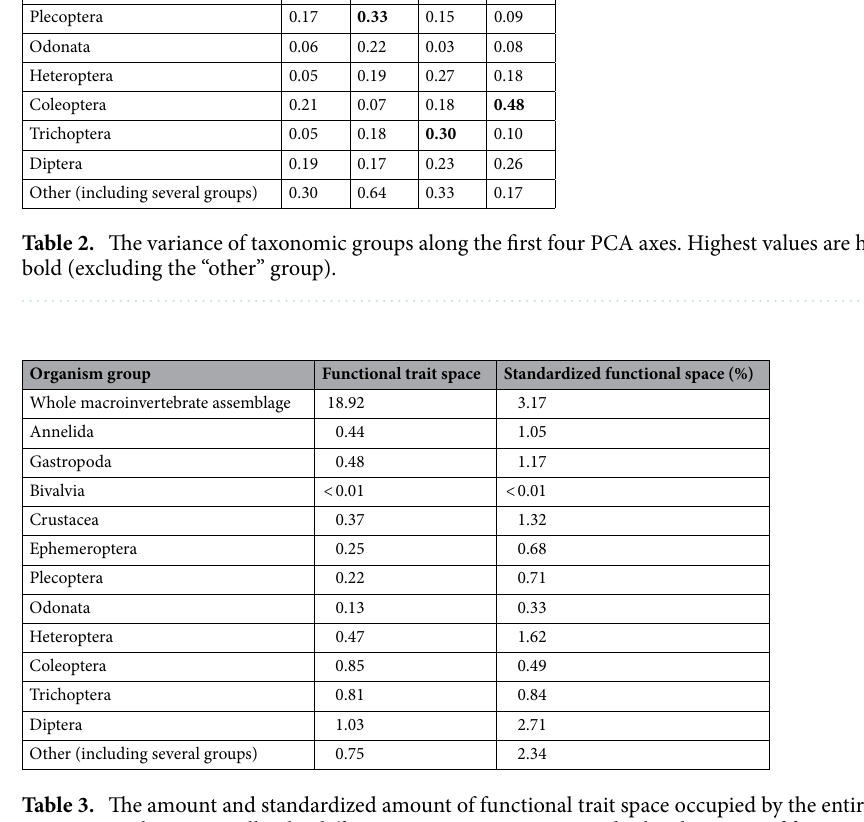
Table 3. The amount and standardized amount of functional trait space occupied by the entire set of macroinvertebrates as well as by different taxonomic groups. Standardized amount of functional trait space expresses the amount of functional trait space per taxon regarding the particular taxonomic